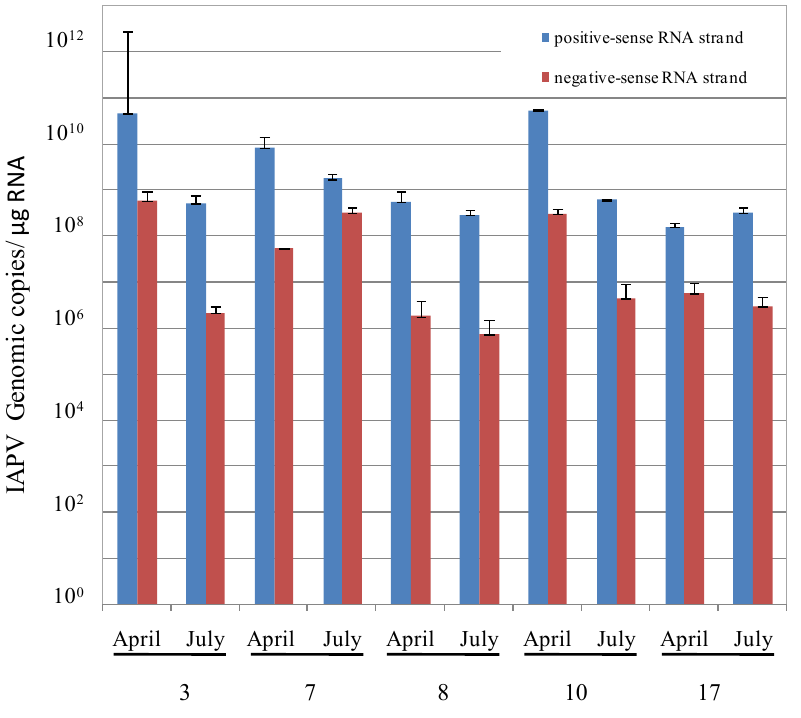
pairs +/− were significantly different (t-test, p <